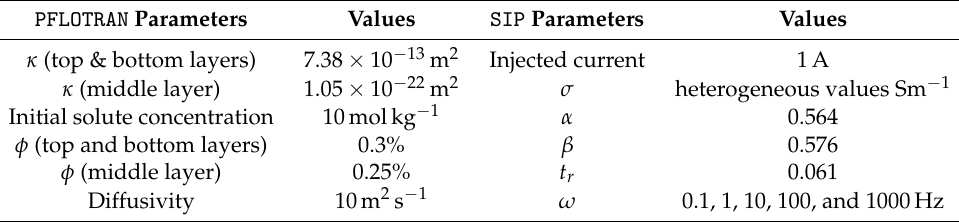
Table 1. PFLOTRAN and SIP parameters used in the model and corresponding